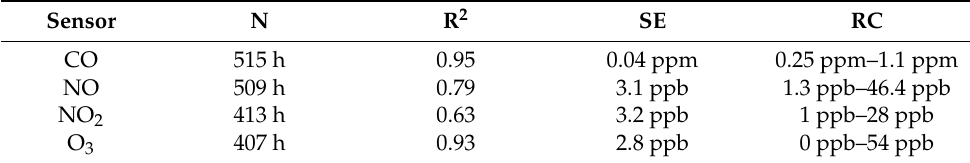
Table 1. Calibration results of B4 gas sensors. N represents the number of hours of calibration for each sensor in the AMS. R 2 is the coefficient of determination of MLR. SE is the standard deviation of mean. RC represents the range of the concentration during the calibration. Sensor N R